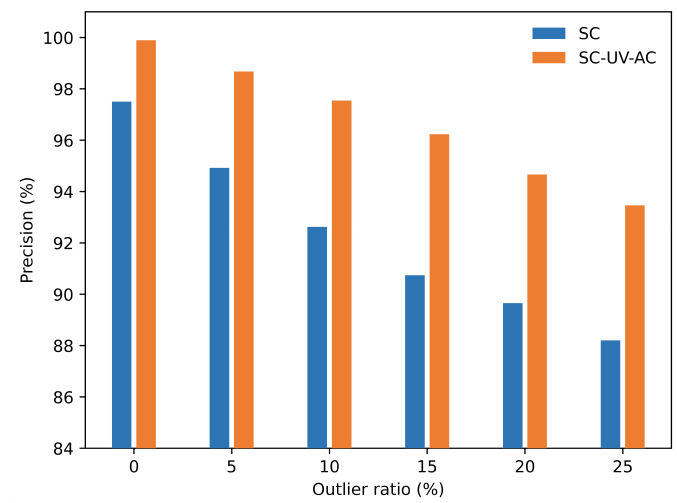
Figure 11. Results of anti-interference test.